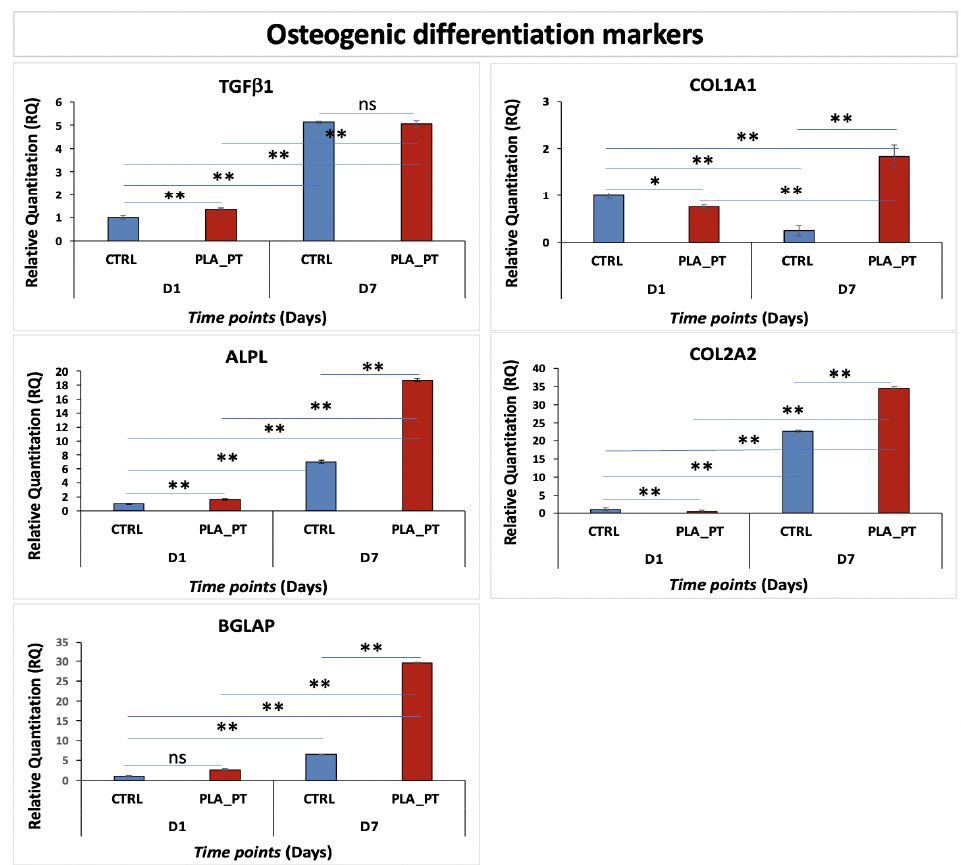
Figure 8. Gene expression profile of hFOB cells cultured on PLA_PT scaffolds for 7 days. Glyceraldehyde-3-phosphate dehydrogenase (GAPDH) has been used as an endogenous control. One-way ANOVA test p -value is reported and * indicates significant ( p < 0.05) differences between groups as reported by the post-hoc test. * p < 0.05; ** p < 0.01; ns = not significant.